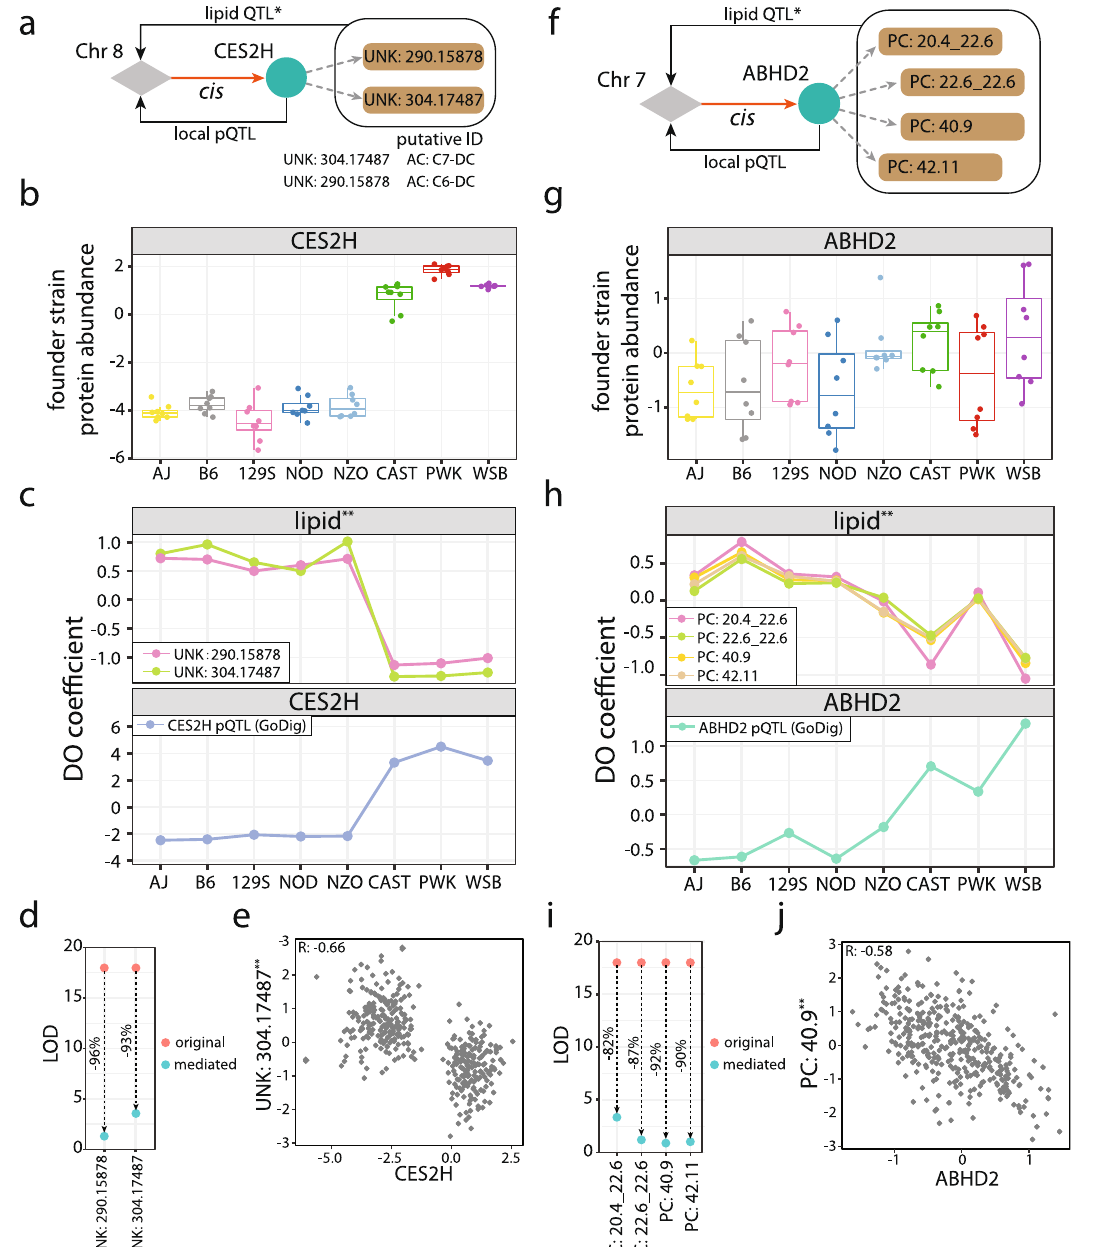
Fig. 6 | Assigning drivers to previously reported lipid QTL detected in DO mouse livers by Linke et al. 19 . a Example of two lipid QTL that map to the same locus on chromosome 8. GoDig analysis identi fi ed a local pQTL regulating the abundance of CES2H and the abundances of two lipids with unknown identities. BasedonfunctionalannotationofCES2Handitshomologsandmassspectraofthe two unknown lipids, the two lipid species are putatively identi fi ed as acylcarnitine species with molecular formulas C 14 H 26 NO 6 (e.g., pimeloylcarnitine) and C 13 H 24 NO 6 (e.g., methylglutarylcarnitine) (Supplementary Fig. 8). b Liver protein abundanceofCES2Hinthe8founderstrains( n =8animalsforeachstrain).Bottom border, interior line, and top border in the box plot represent the 1st quartile, median,and3rdquartile,respectively.SourcedataareprovidedintheSourceData fi le. c Founder allele effects observed at the QTL for the two unknown lipids and local pQTL for CES2H. The lipid QTL have allele effects that are negatively corre- latedwith thatofCES2H(meanPearsonR: − 0.98).Source data areprovided in the Source Data fi le. d Mediation analysis of the two unknown lipids ’ levels through